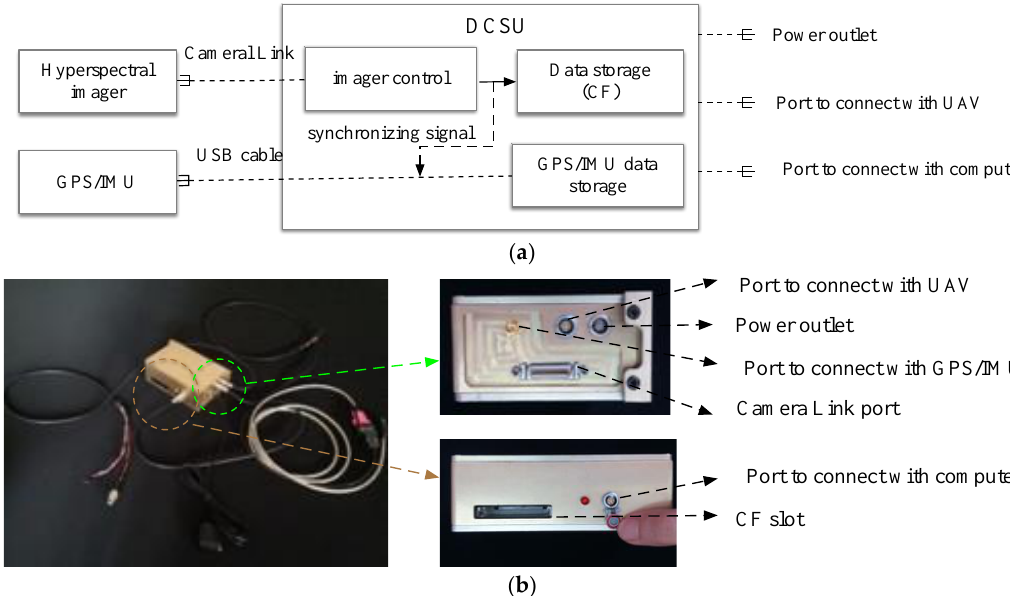
Figure 3. ( a ) Schematic and ( b ) photograph of data collection and storage unit (DCSU).